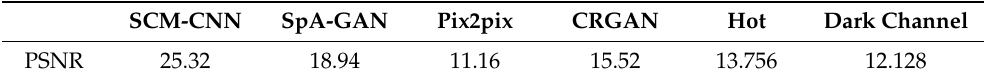
Table 1. The score of psnr. We utilized the WHUS2-CR dataset to validate the accuracy of our model on actual remote sensing images [29]. Specifically, we selected a subset of 10 high-quality image pairs with and without clouds for comparative